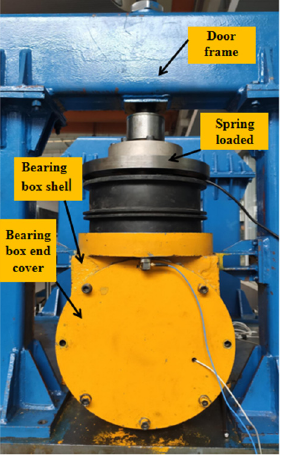
Figure 3. Side view of the bearing system. Table 1. Axle box bearing dimension parameters.